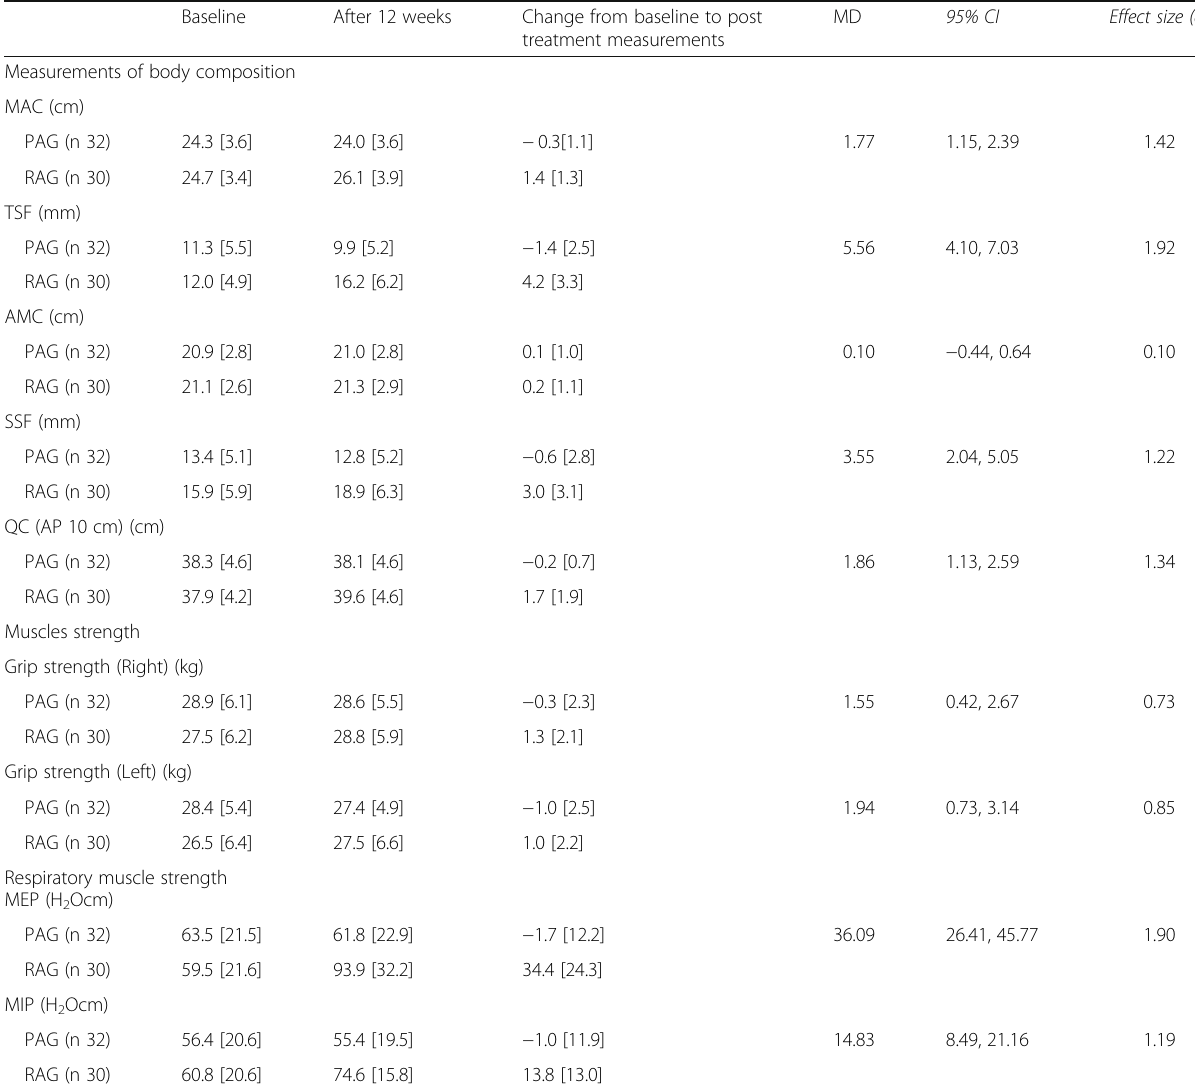
Table 3 Changes in the body composition and muscles strength Baseline After 12 weeks Change from baseline to post MD 95% CI treatment measurements Measurements of body